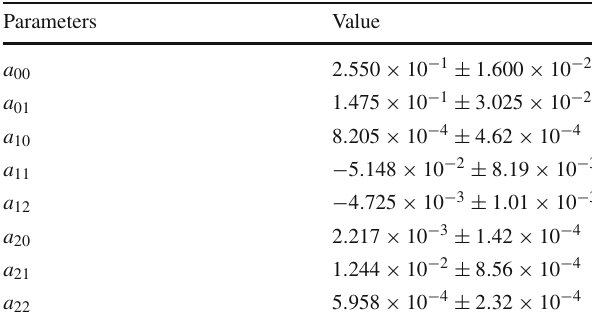
Table 2 The effective parameters used in Appendix A with respect to Eqs. (9) and (10) in Refs. [61,62]